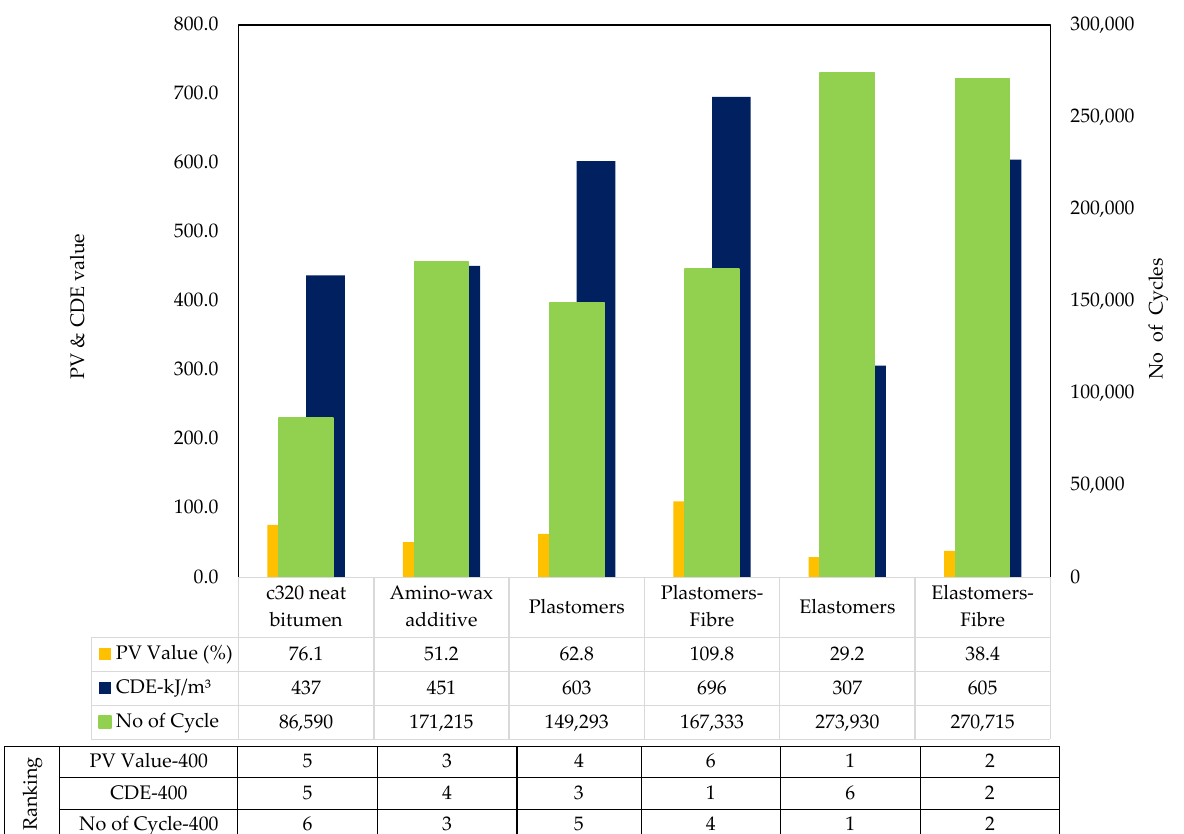
Figure 11. Ranking and properties of HMA mixes@400 μ strain for FBBT tests.